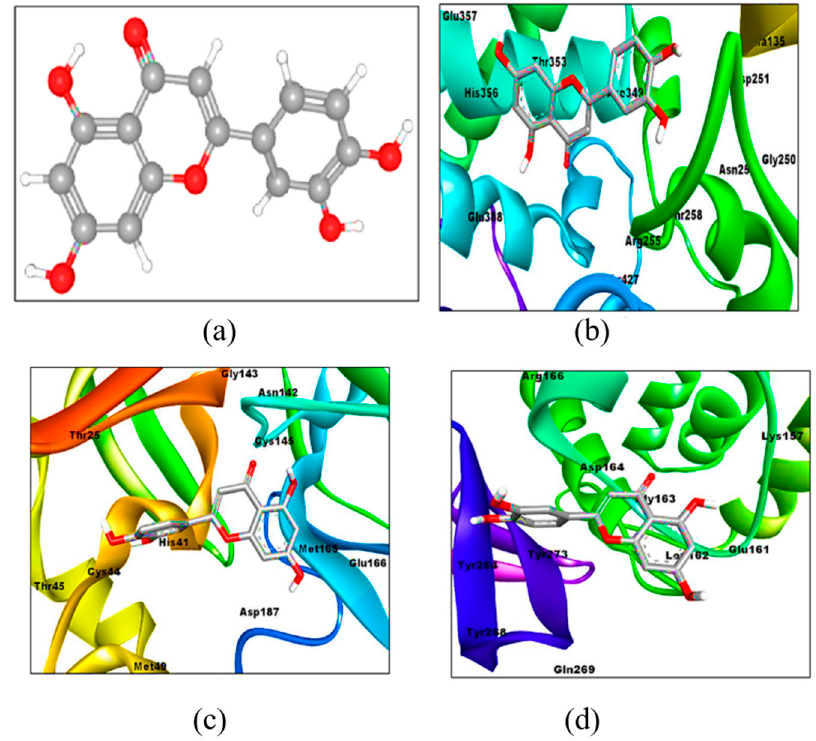
Figure 3. 3D structure of luteolin ( a ) and binding poses involving its interaction within the active sites of ACE-II ( b ), Mpro/3CLpro ( c ), and PLpro ( d ). Modified with permission from Shawan et al. [86], Bulletin of the National Research Centre, Springer Open, 2021, http://creativecommons.org/licenses/by/4.0/.